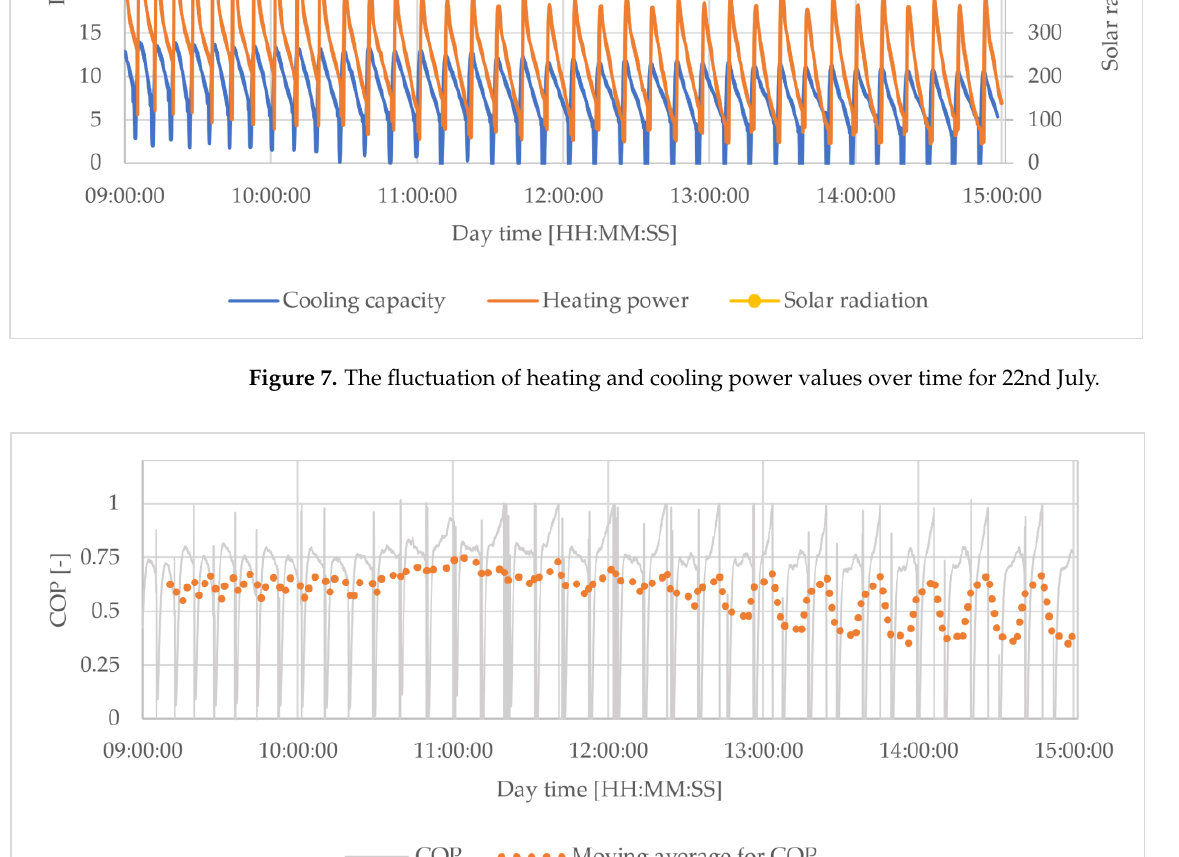
Figure 8. COP values over time for 22nd July.